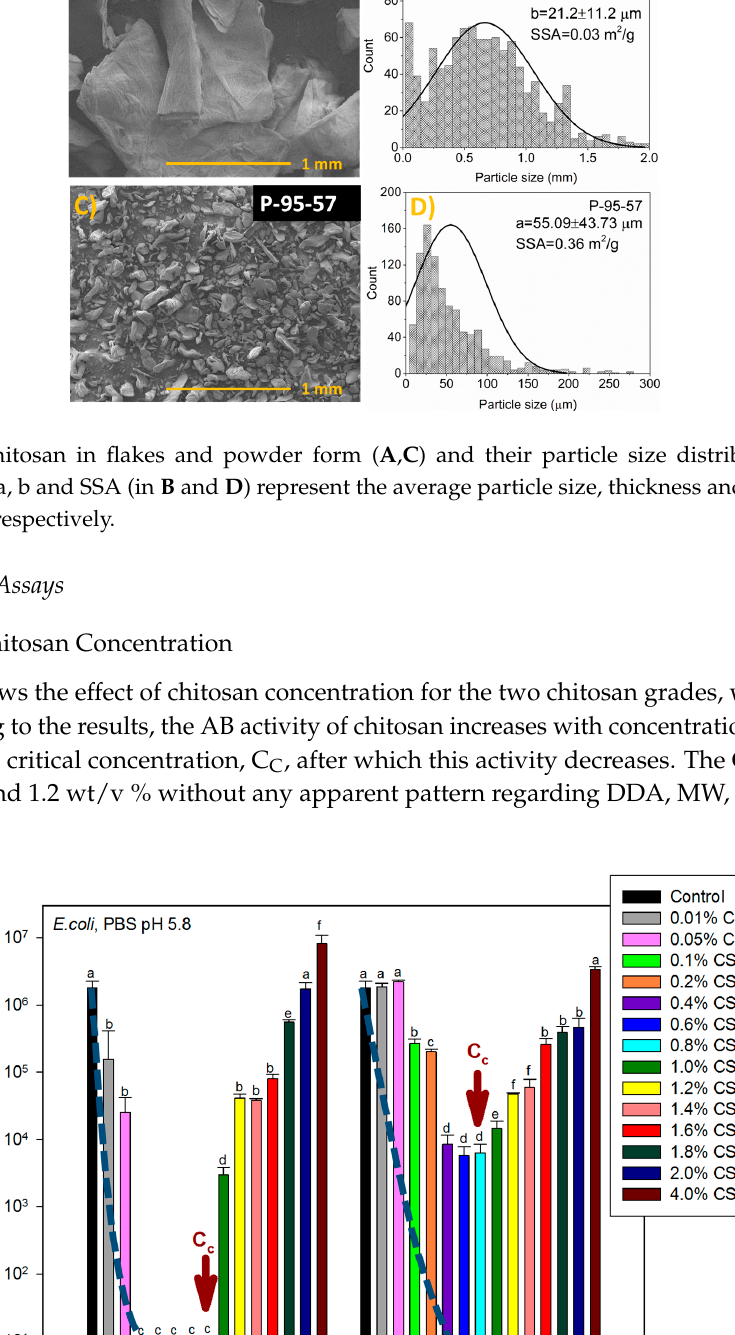
Figure 3. Effect of chitosan concentration in PBS on the number of viable survivors. C c is the critical concentration above which the AB activity of chitosan decreases. Dashed lines represent the reduction in bacterial concentration after deproteinization. Samples are P-95-57 (powder) and F-90-207 (flakes). The number of viable organisms was the same after 18 and 48 h incubation on the agar plates, suggesting that recovery from sub-lethal injury had not taken place. For each chitosan grade, means that do not share a letter are significantly different with a confidence level of 95% by Tukey Pairwise Comparisons.